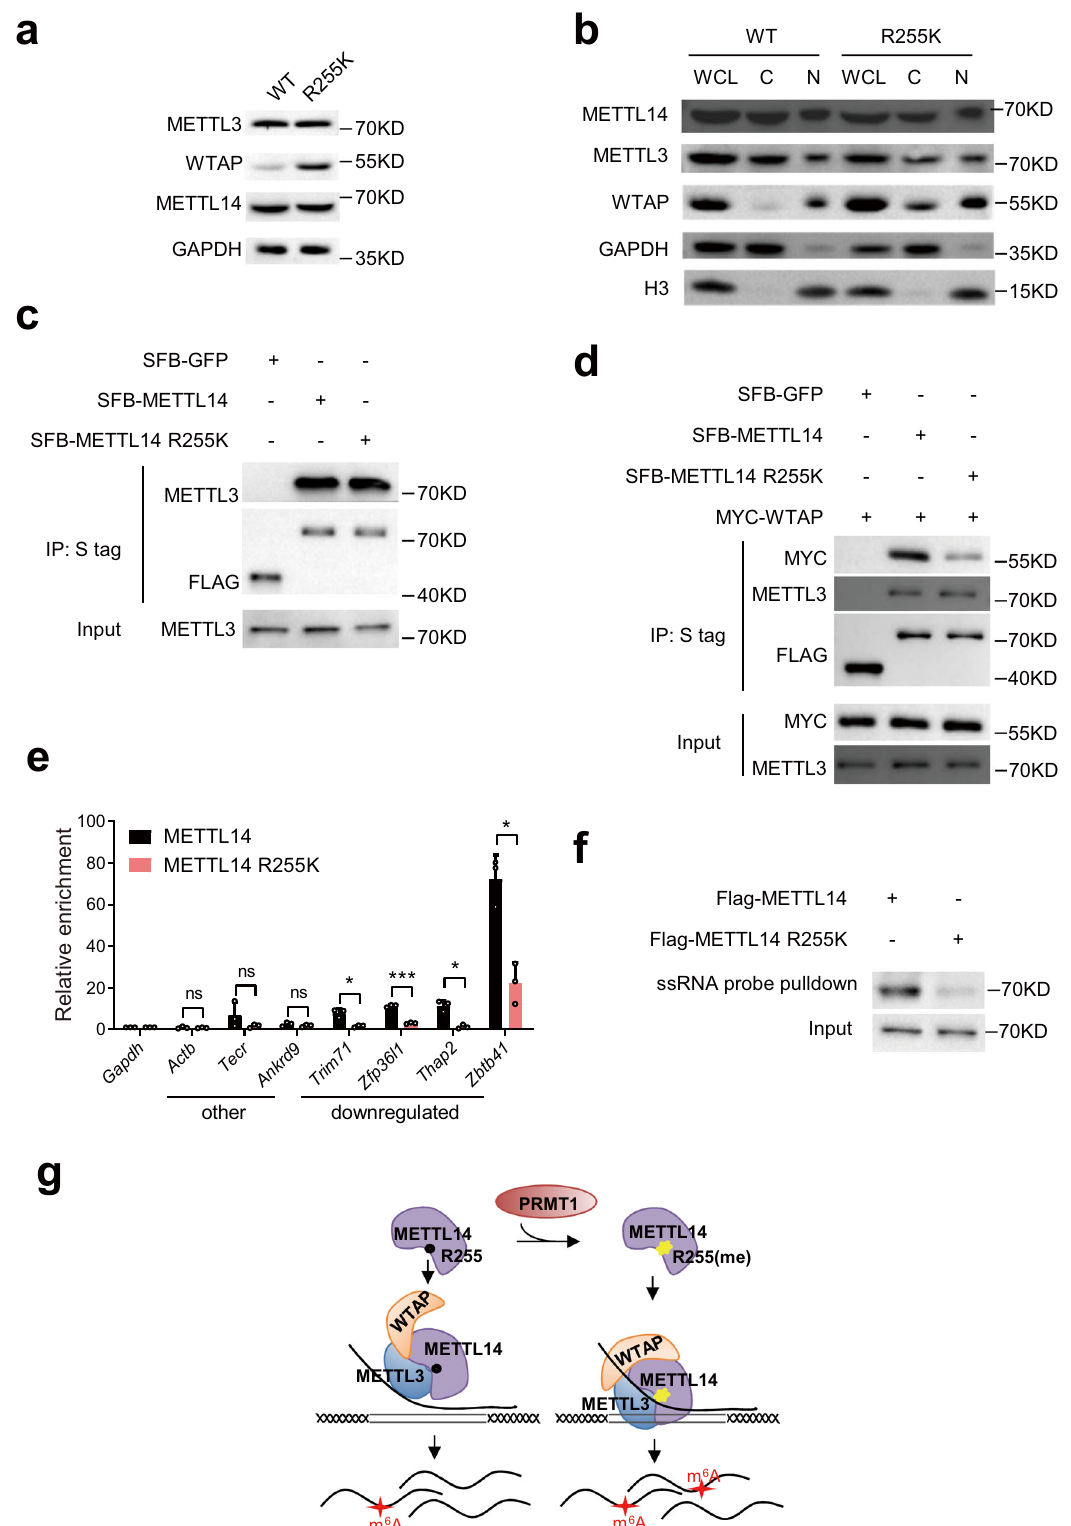
qPCR. We found that the METTL14 R255K exhibited reduced RNA-binding ability for transcripts with decreased m 6 A mod- conducted using a single-stranded RNA probe containing the m 6 A motif RRACH. Less METTL14 R255K protein was pulled down compared with WT METTL14, suggesting that METTL14